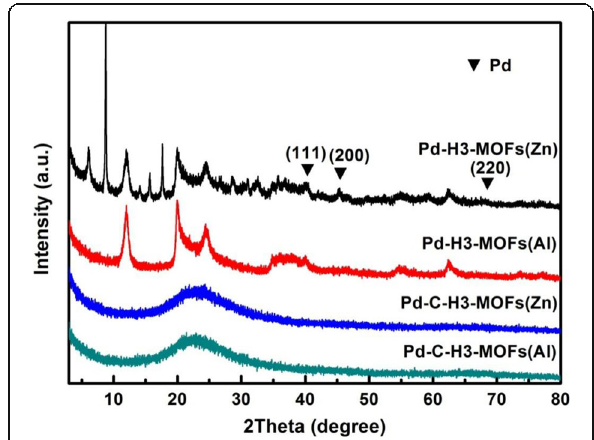
Fig. 4 XRD patterns of Pd-H3-MOFs(Zn), Pd-H3-MOFs(Al), Pd-C-H3- MOFs(Zn), and Pd-C-H3-MOFs(Al)